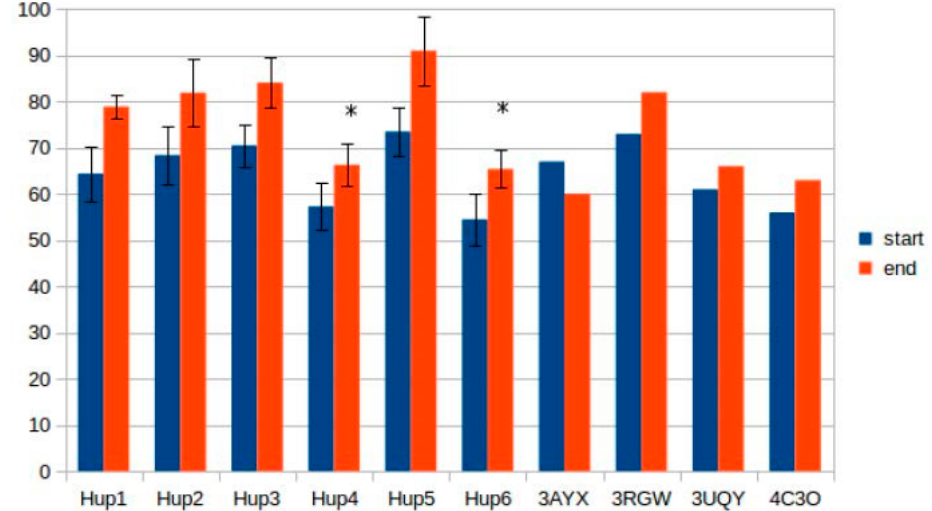
Figure 10. Number of ionic pairs in the large subunits of HupSL hydrogenases. Hup1 -HupSL from Tca. roseopersicina ; Hup2 -HupSL from Rba. capsulatus ; Hup3 -HupSL from Rba. sphaeroides ; Hup4 -HupSL from Rps. palustris ; Hup5 -HupSL from Rvi. gelatinosus ; Hup6 -HupSL from Rsp. rubrum ; 3AYX -HoxKG from H. marinus ; 3RGW -HoxKG from R. eutropha ; 3UQY -HyaAB from E. coli ; 4C3O -HydAB from S. enterica. Start-models (structures) before energy minimization; end-models (structures) after energy minimization. The data are represented as mean ± 2 × SD. Significantly low results (ranges not overlapping with the others in the subgroup) are marked by asterisks.